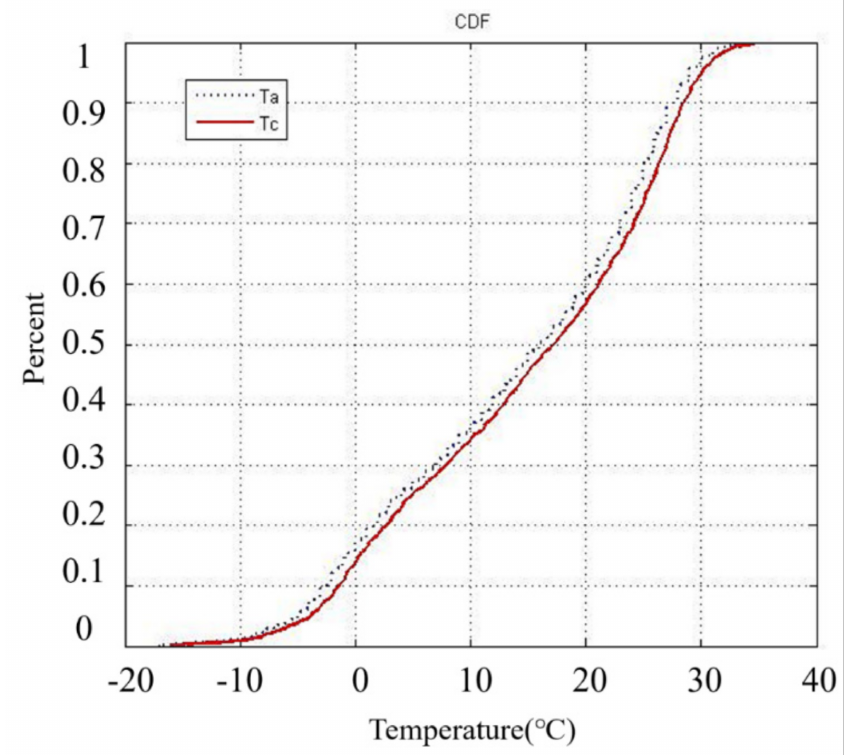
Figure 8. The cumulative distribution function of the ambient temperature and the bus capaci- tor